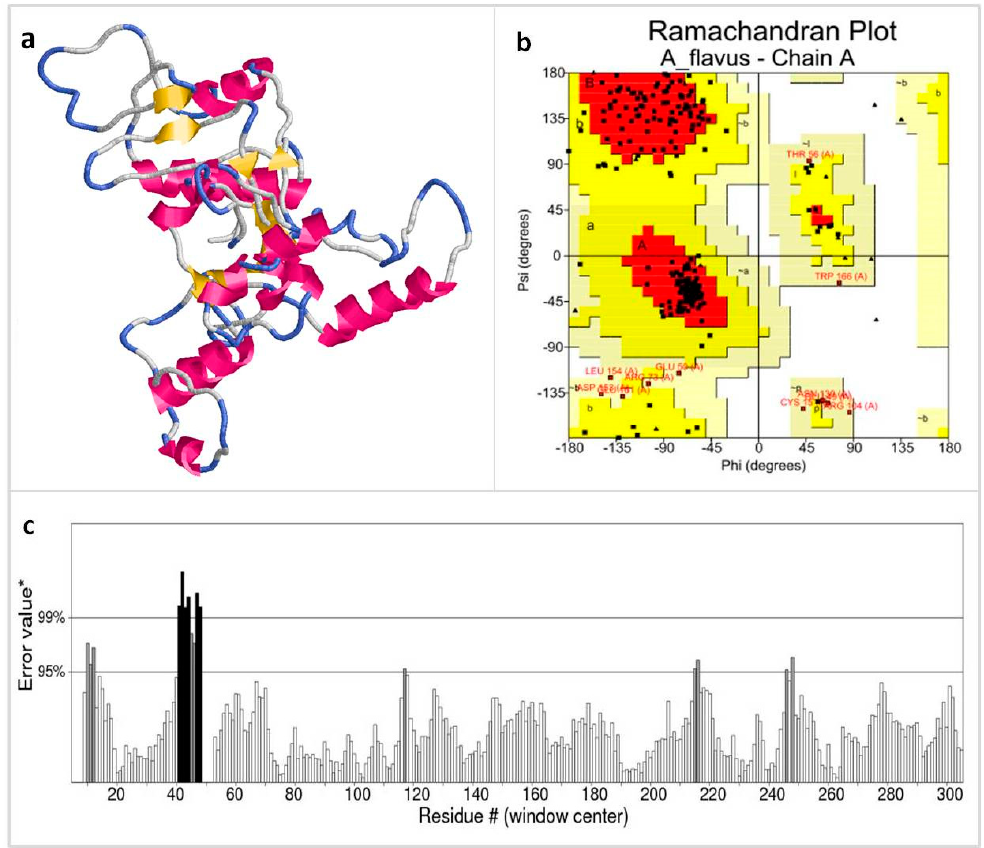
Figure 1. Theoretical model of the RNA polymerase (RNAP) structure from Aspergillus flavus and model validation through the Structural Analysis and Verification Server (SAVES) server. ( a ) The 3D structure of the built protein in a cartoon representation with the following structure colors: Pink (helices), Yellow (sheets), and blue (loop); ( b ) model validation by a Ramachandran plot; ( c ) ERRAT Plot showing the generated model at a good high resolution, as the regions of the modeled structure that can be rejected at 95% and 99% confidence is very